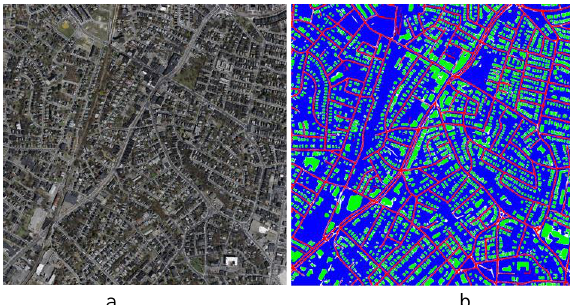
Figure 2. An example for CNN, (a) test image, (b) the result obtained by convololutional network and post-processing stage.